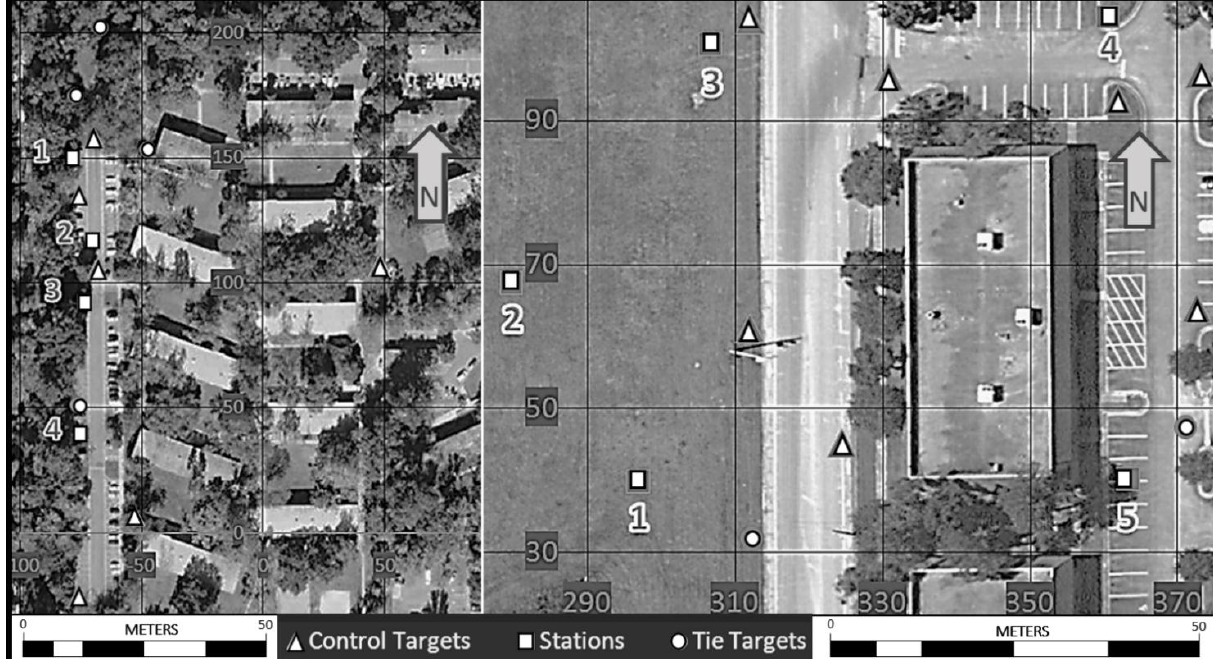
Figure 3. Test locations at Site 1 in Corry Village ( left ) and Site 2 in Orlando ( right